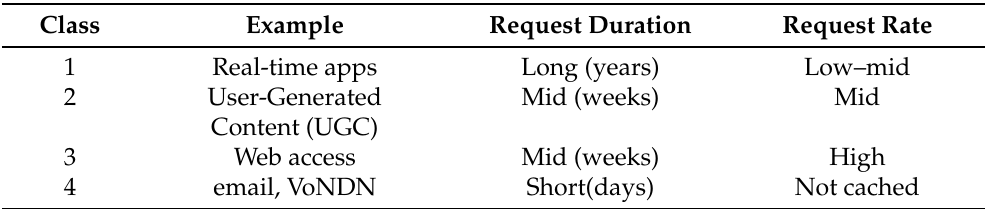
Table 1. Class of